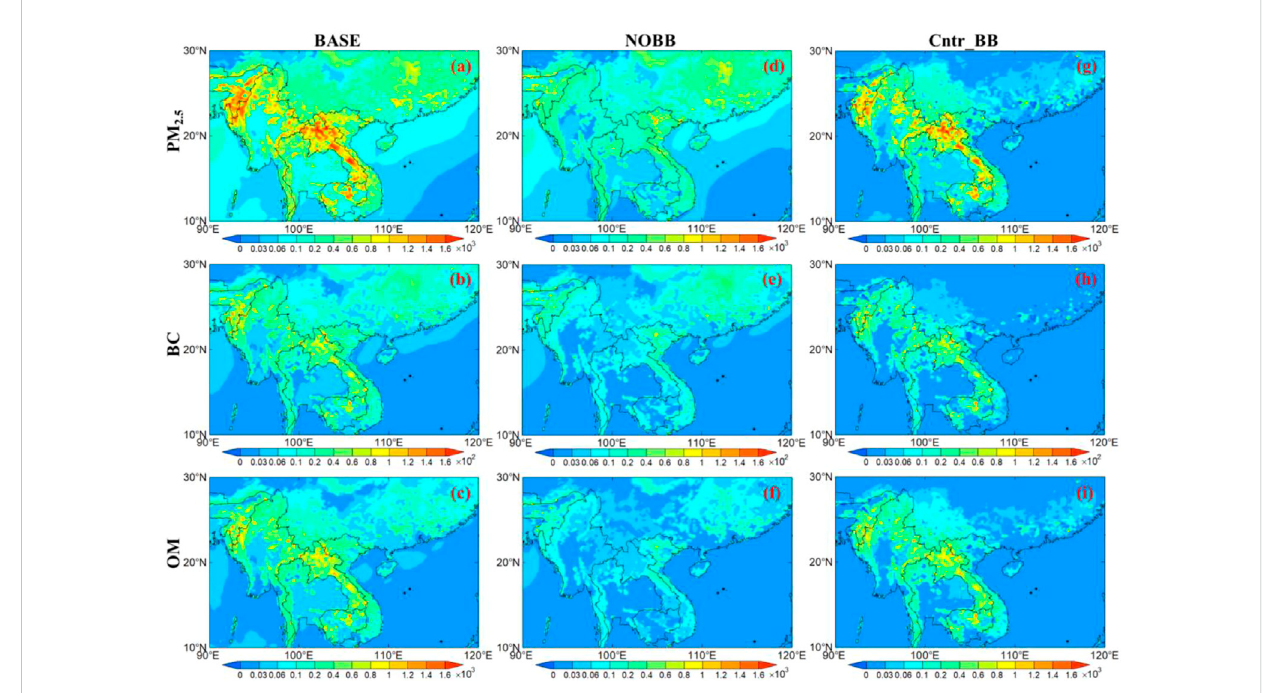
FIGURE 5 Modeled period mean aerosol deposition fl uxes (units: mg/m 2 /month) of (A, D, G) PM 2.5 , (B, E, H) BC, and (C,F,I) OM due to (A – C) all emissions (BASE), (D – F) emissions other than biomass burning (NOBB), and (G – I) biomass burning